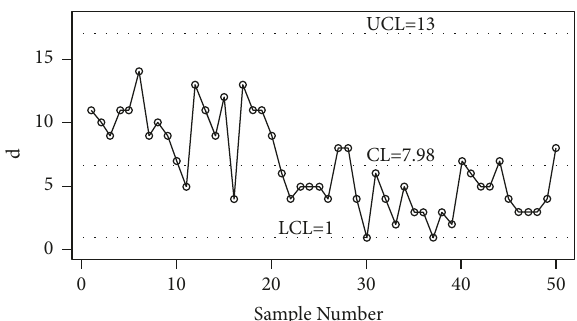
Figure 2: The single sampling control chart for simulated